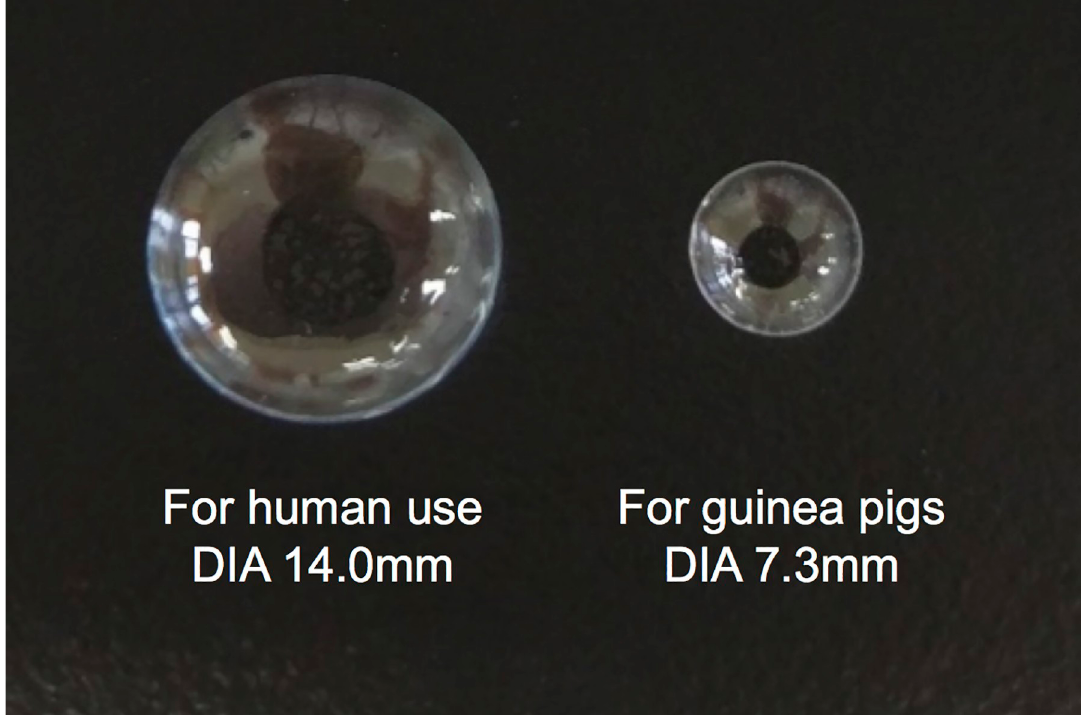
Fig 2. An epinastine hydrochloride-releasing soft contact lens (EH-SCL) for guinea pigs. An EH-SCL for guinea pigs is compared to an SCL for human use. DIA: diameter.